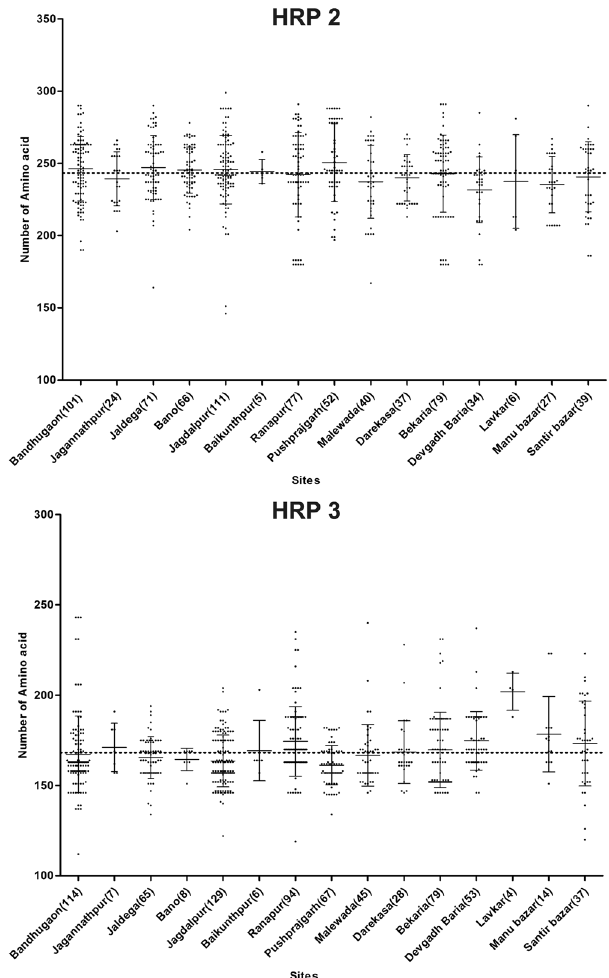
Figure 2. The variation in the length of amino acids in Pf HRP2 and Pf HRP3 protein from study sites. Number in brackets indicates the number of samples. The dotted line indicates the country mean. ^ The mean is significantly higher than the country mean (p < 0.05); # the mean number is significantly lower than the country